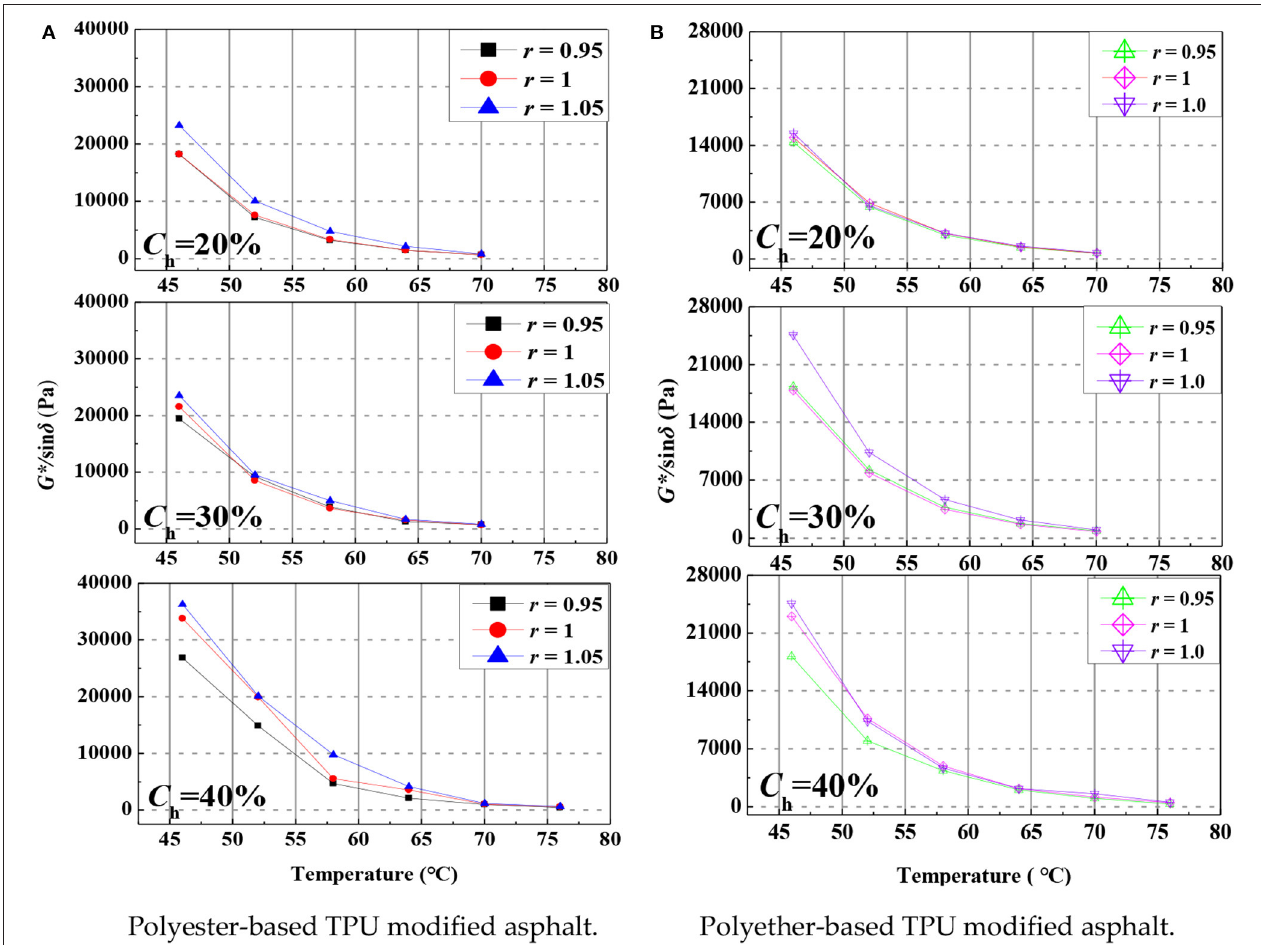
FIGURE 28 | DSR test results of different samples. (A) Polyester-based TPU-modified asphalt. (B) Polyether-based TPU-modified asphalt.